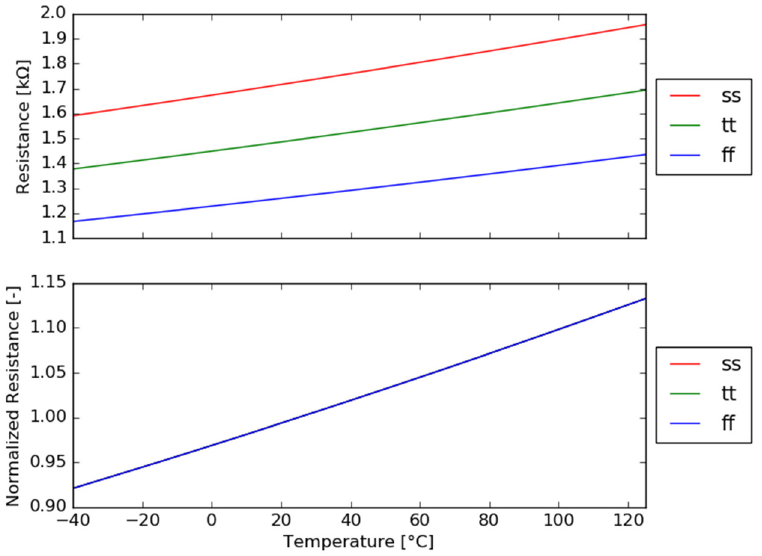
Figure 14. Process corner simulations of the resistance of the on-chip calibration resistor.